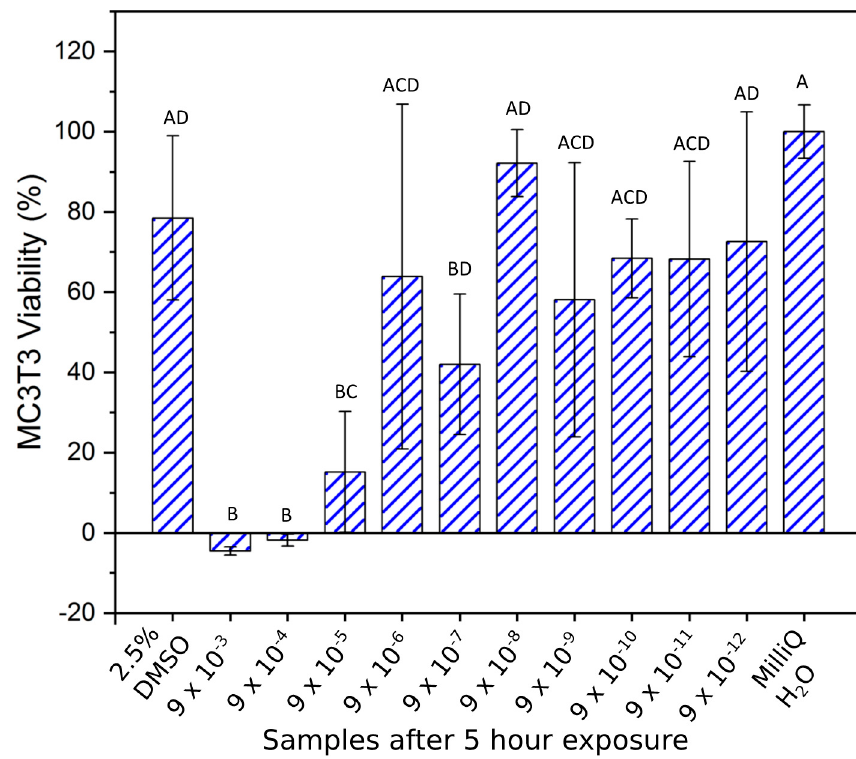
Figure 5. MC3T3 cell viability (mean ± SD) investigation after 5 h of Cu ion exposure. Brown–Forsythe: F (1, 10) = 1.54, p = 0.161. One-way ANOVA: F = 9.92 ( p < 0.001). Note: Samples indicated